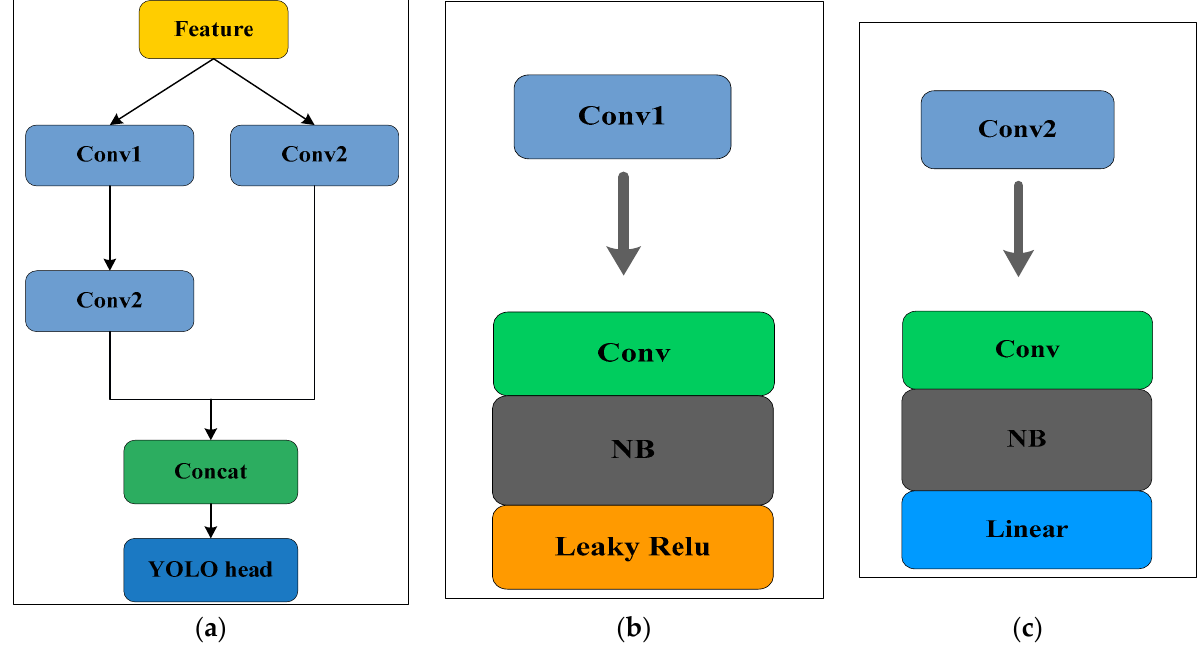
Figure 3. EC component. ( a ) structure of EC; ( b ) Convolution 1; ( c ) Convolution